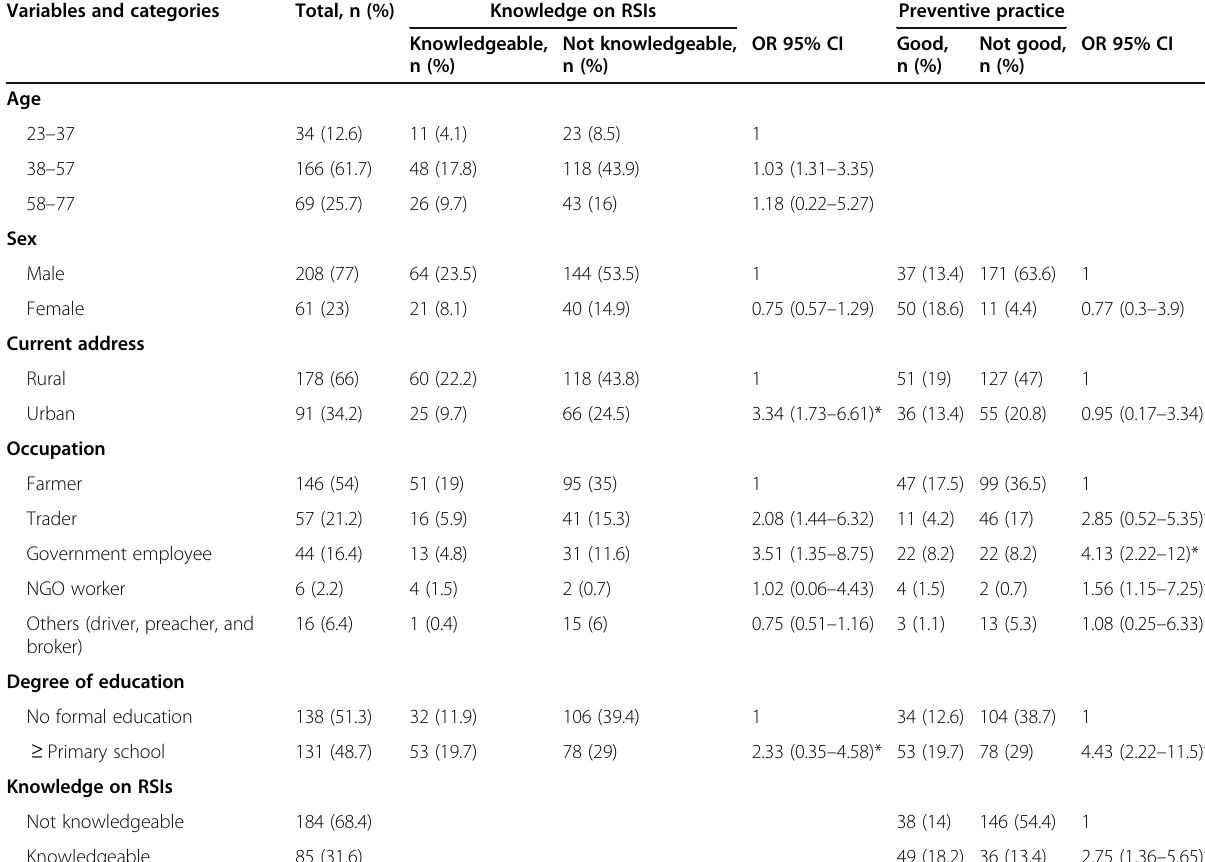
Table 3 Factors associated with knowledge and preventive practices of LFs on RSIs in the Kembata Tembaro zone ( n = 269 farmers) Variables and